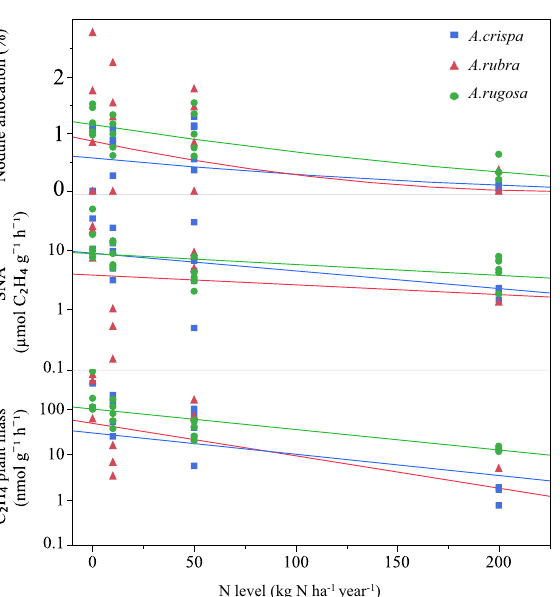
Figure 2. The effect of soil N level on the proportion biomass allocated to nodules, acetylene reduced per nodule mass (SNA) and per plant